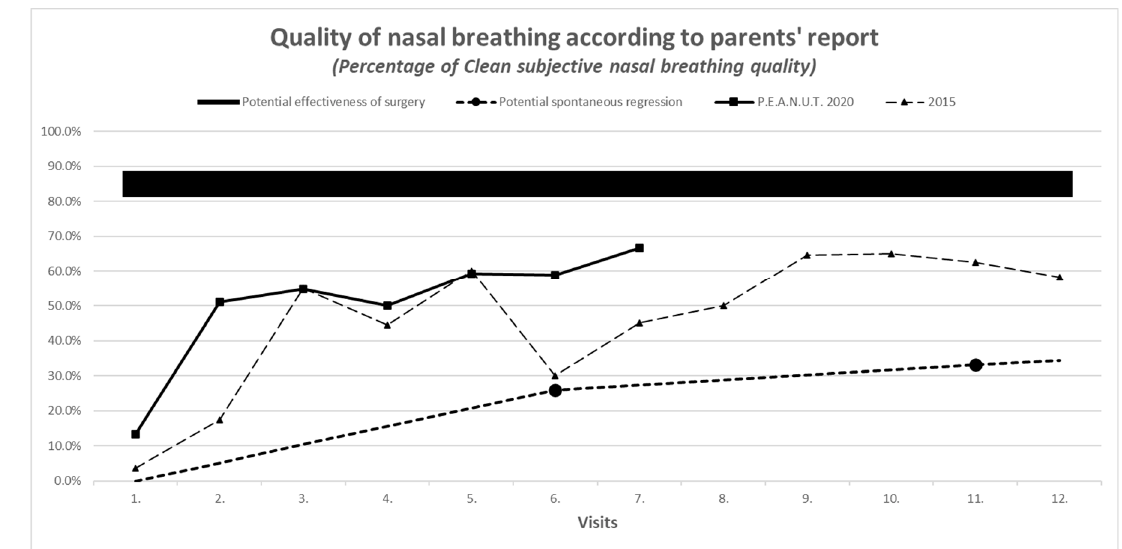
Figure 3. Parents’ subjective reports on nasal breathing.